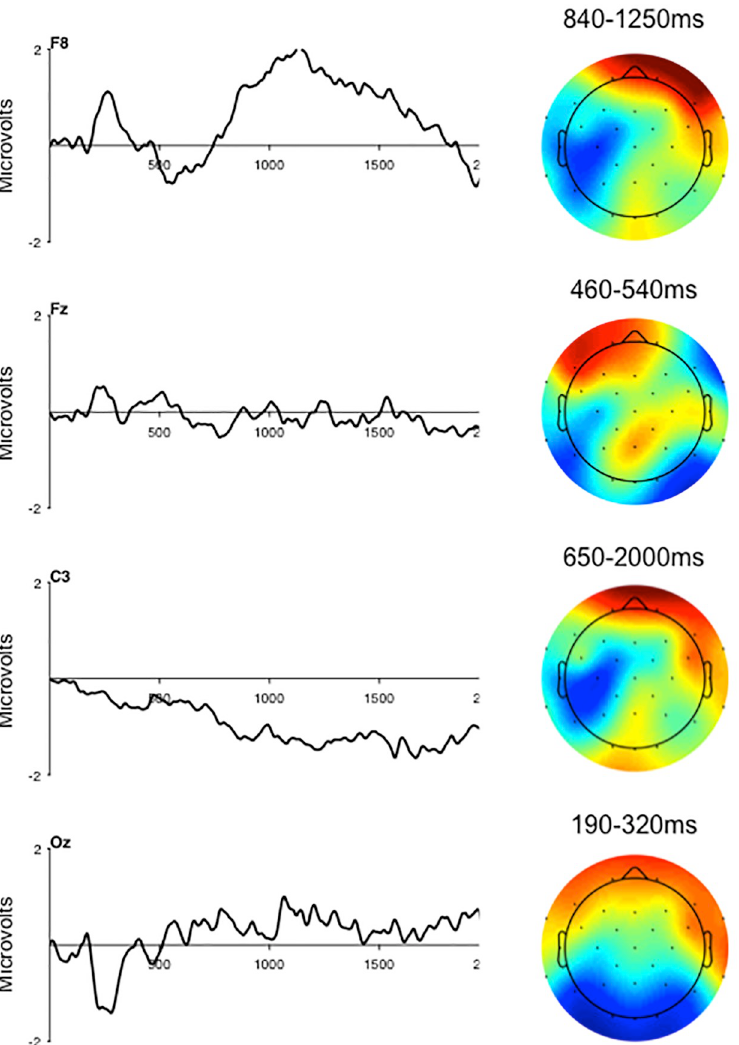
Fig 3. ERP saliences from the TaskPLS analysis at four electrodes and topography maps demonstrating the spatial distribution of the electrode saliences for the first latent variable that contrasted minor and major violation scenarios with control scenarios. The times represent point where the bootstrap ratio exceeded 2.0. Topographic maps represent the mean voltage over the time window indicated and are to maximize the voltage gradient, ranging from +/-1.0–2.0